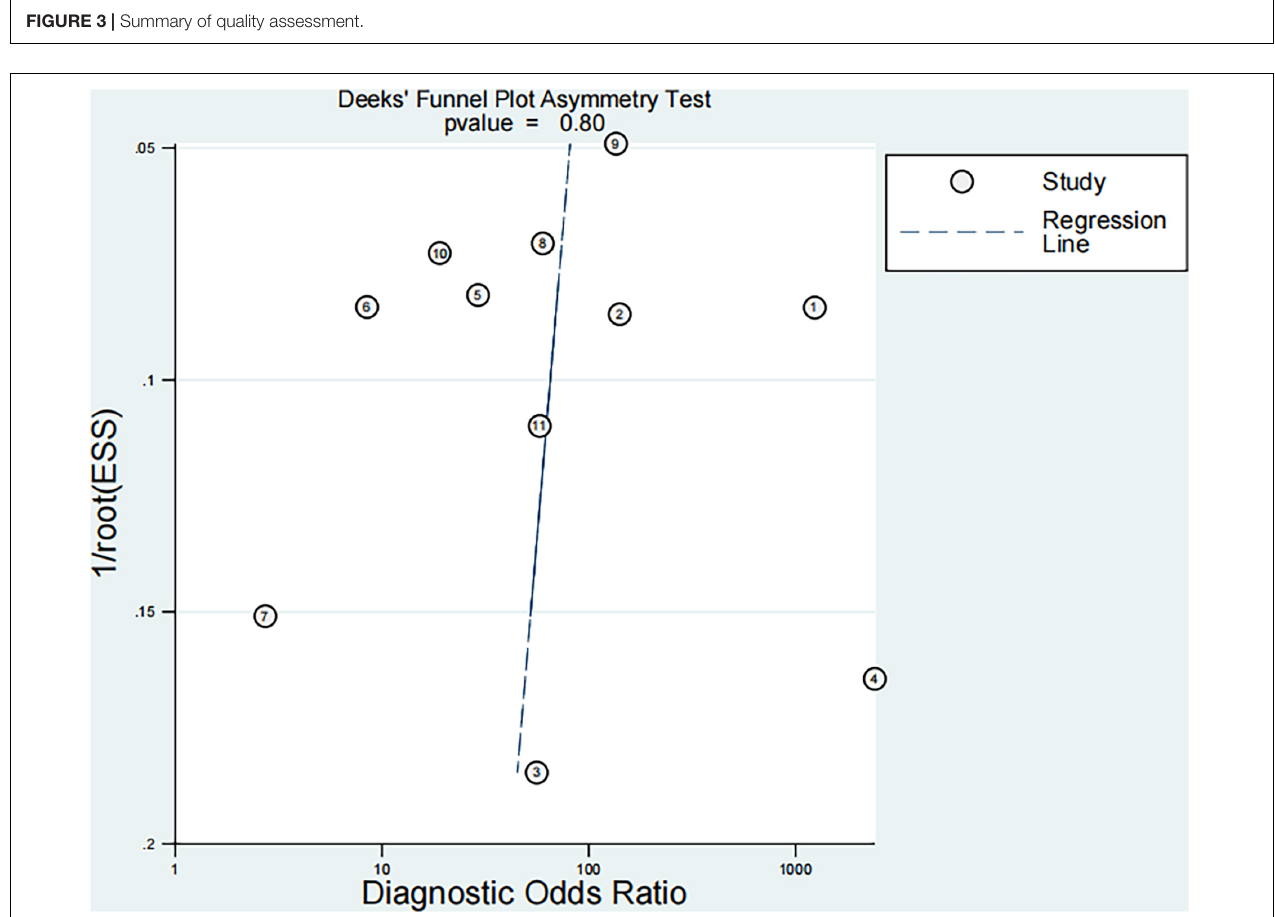
FIGURE 4 | Publication